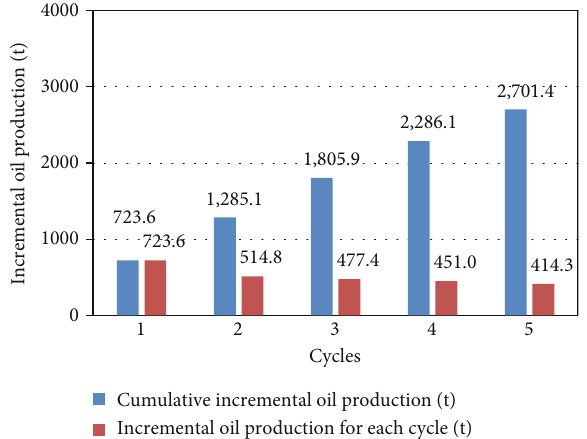
Figure 19: Incremental oil production through CO under di ff erent cycles.